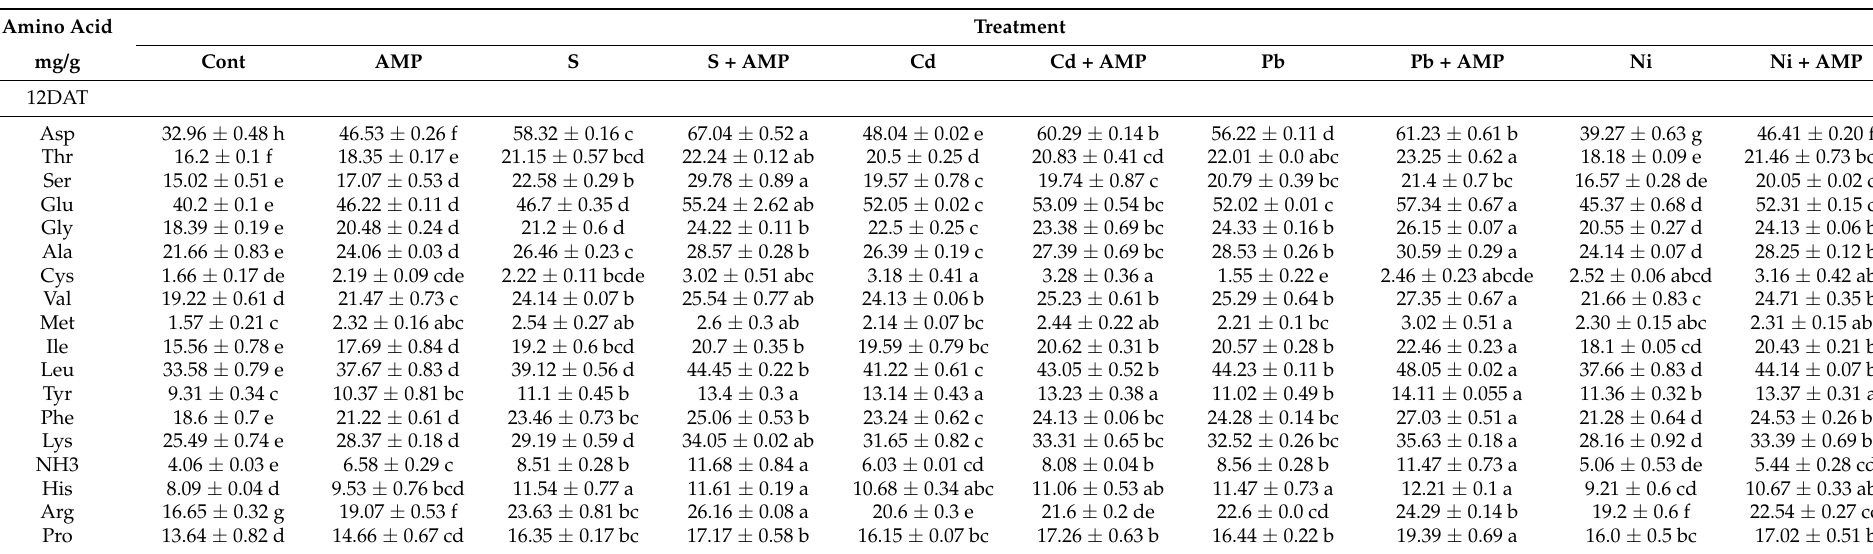
Table 2. Effect of ampelopsin application on the amino acid content of soybean plants grown under normal and stress conditions, after 12 days of treatment (12DAT). Amino Acid